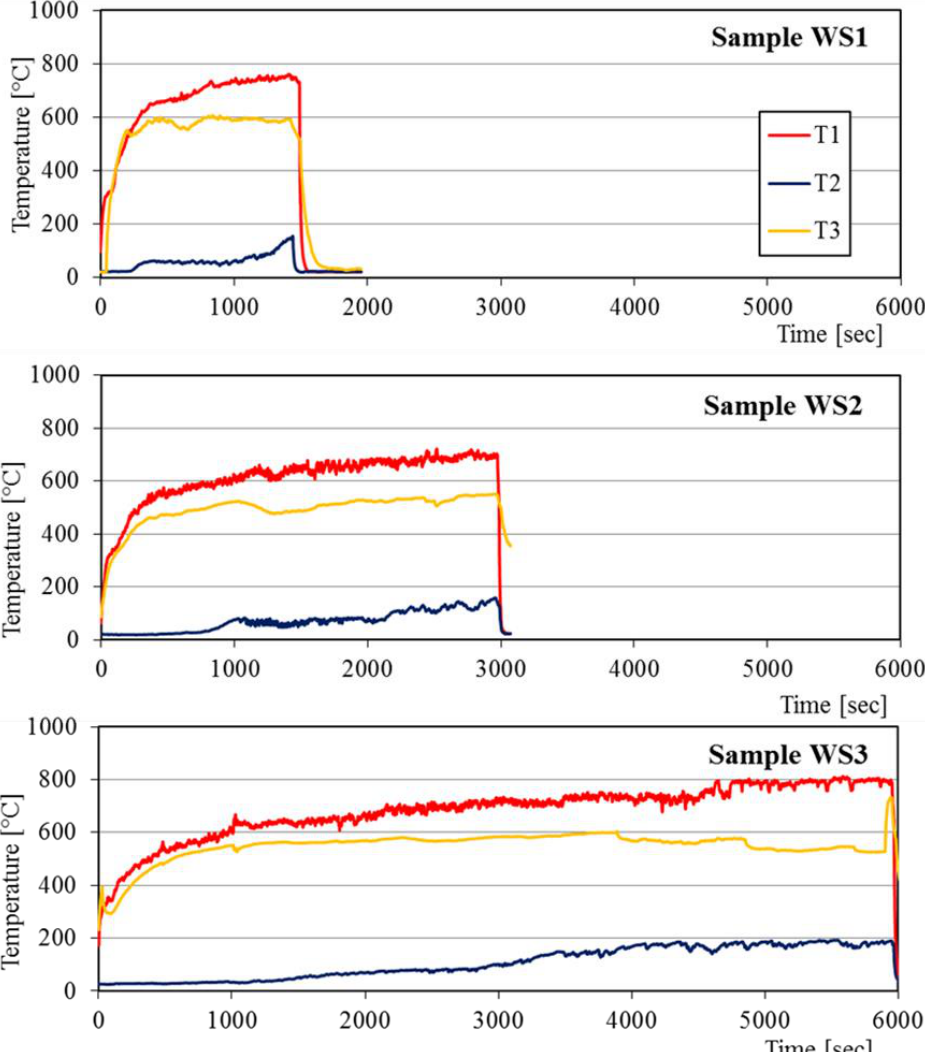
Figure 10. Temperature-time curves of fire resistance tests for the wood samples.